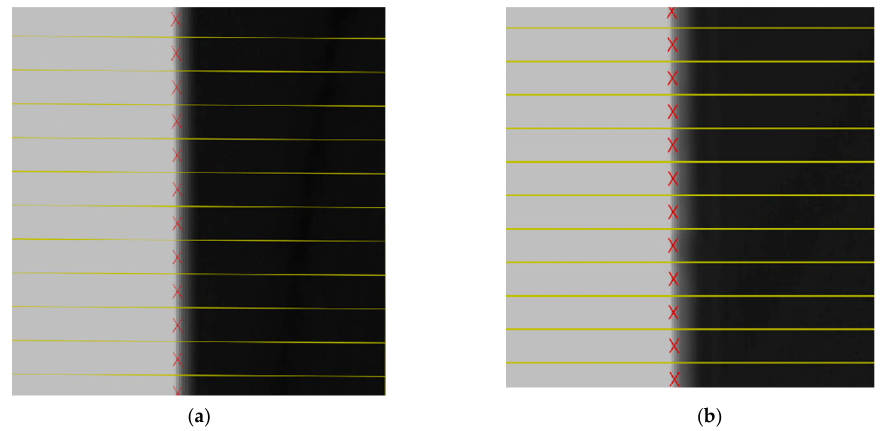
Figure 12. The subpixel coordinates of the images captured by camera. ( a ) The image captured by the left camera. ( b ) The image captured by the right camera.